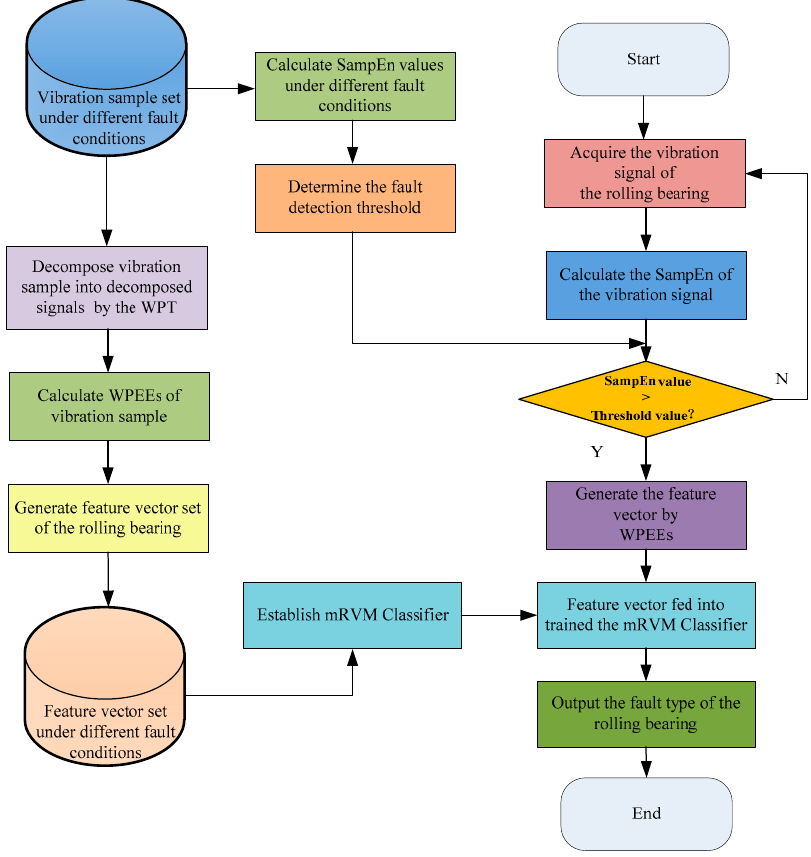
Figure 3. Flow chart of the proposed fault diagnosis method.